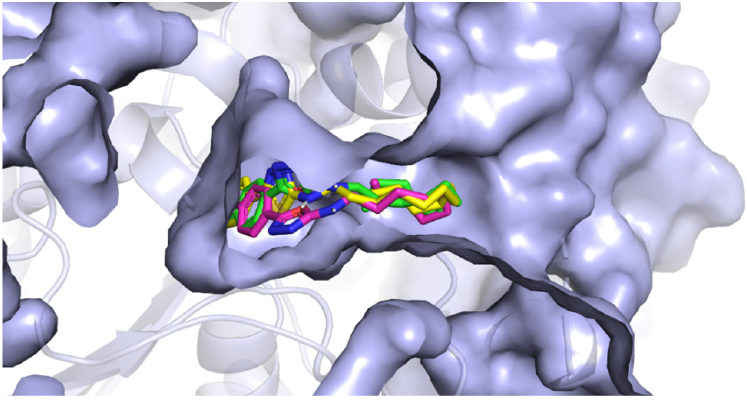
Figure 5. The position of 3b , 3c , and 3t in the cavity of AChE.